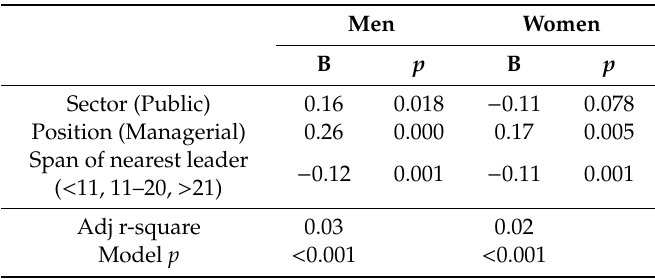
Table 2. Multiple regression analysis with PSC-4 (range 1–5) as the dependent variable; separate analyses for men and women, based on the random sample of the Swedish working population ( n =